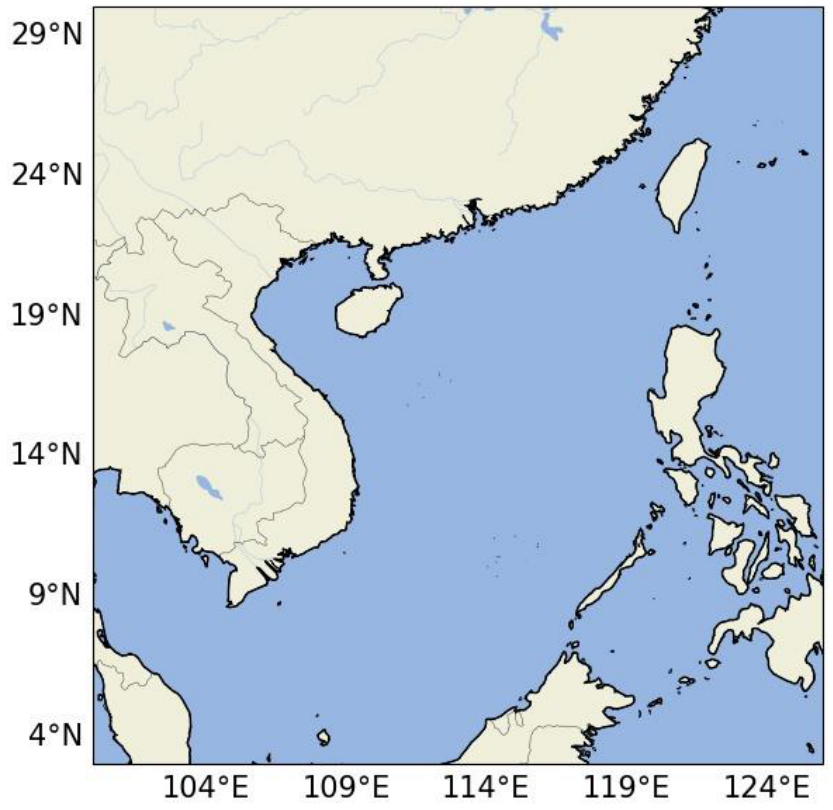
Figure 1. Topographic map of the South China Sea.